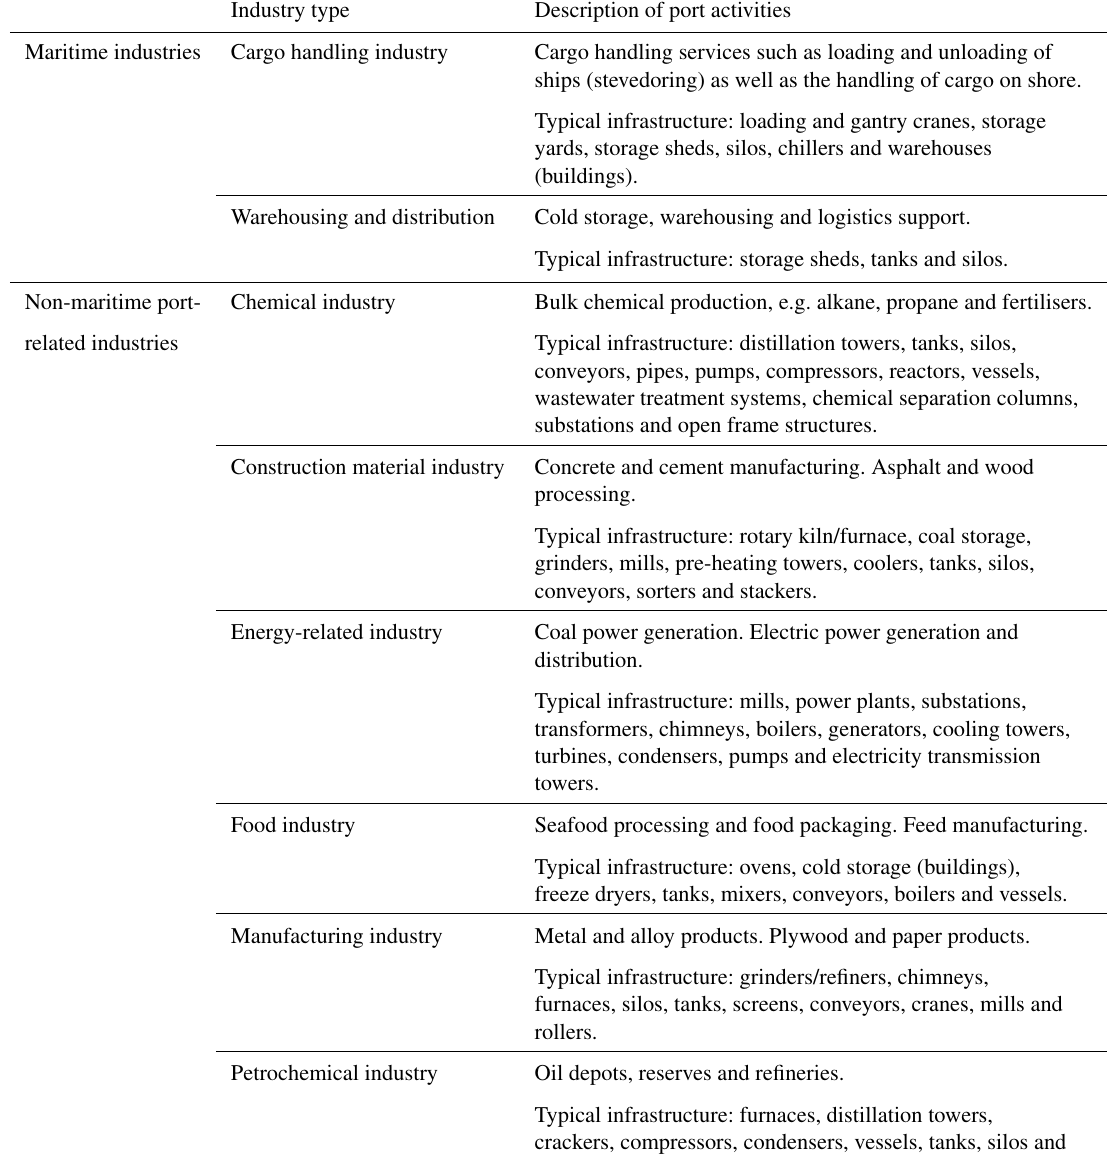
Table 2. Proposed classification for port activities found in the Tohoku